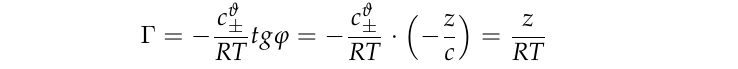
This way, adsorption values of G are calculated for a number of points on the curve and, according to the calculated data, an adsorption isotherm is constructed in the coordinates G = f ( c ) (Figure